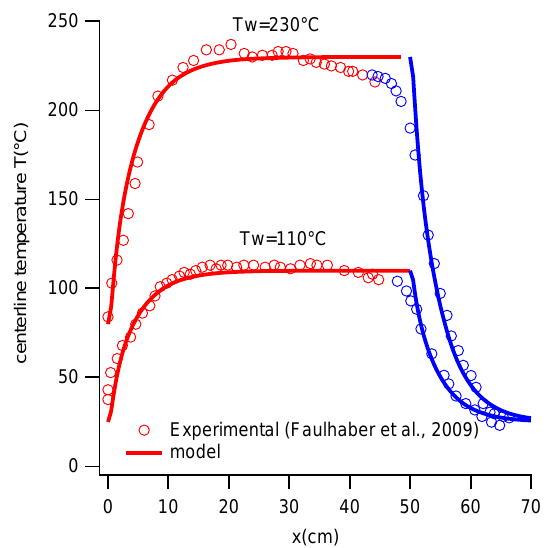
Fig. 2. Modeled and experimental centerline temperature in the heating and cooling sections of Huffman et al. (2008) thermode- nuder. Note that the initial fluid temperature in this calculation is the centerline temperature at the inlet of the active heating zone (i.e. tube covered with heating